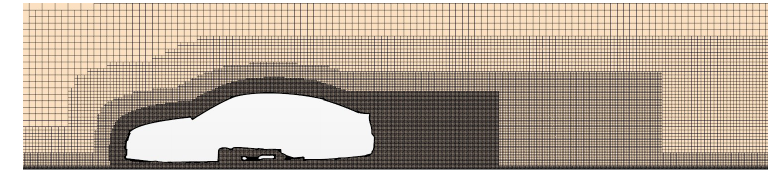
Figure 3. Side View of Meshing Scheme for DrivAer.